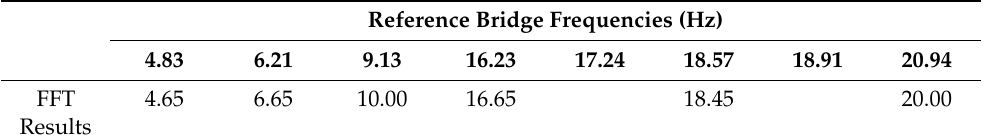
Table 5. Identified bridge frequencies through the front tire acceleration time history.